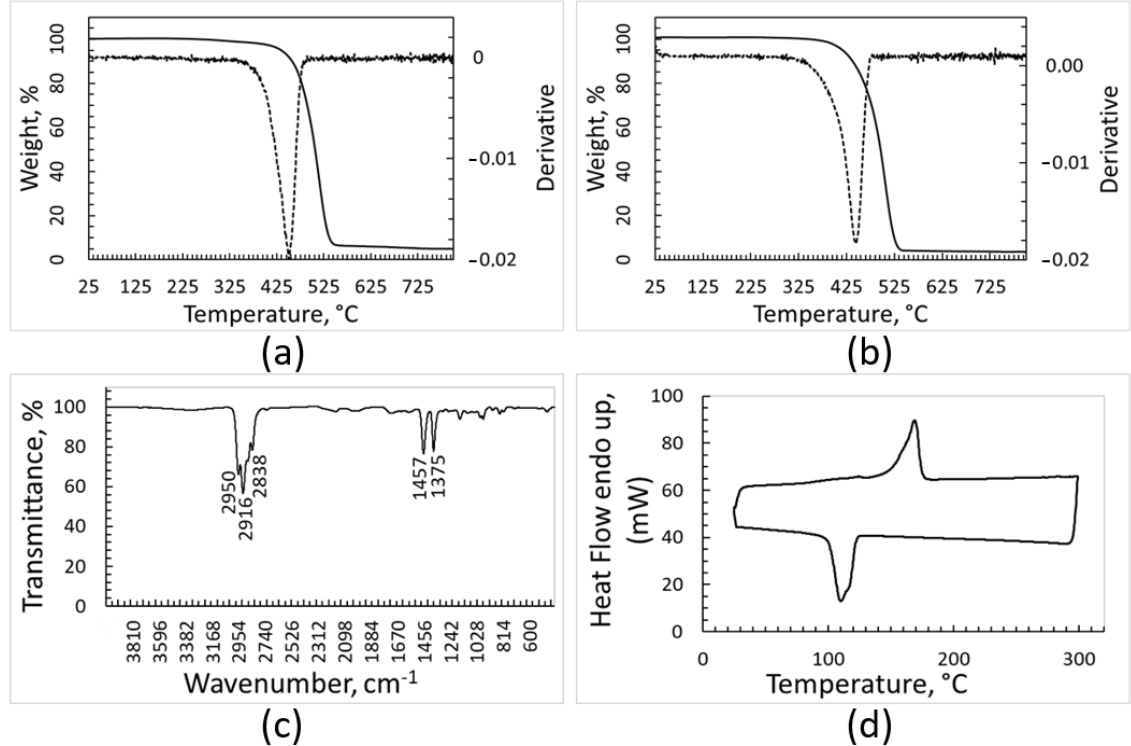
Figure 5. Characterization of the PP fraction: TGA and DTGA (dotted line) curves recorded under argon ( a ), TGA and DTGA recorded under air ( b ), FT-IR spectrum ( c ), DSC heating and cooling curves (upper and lower curve, respectively) recorded under nitrogen atmosphere ( d ).